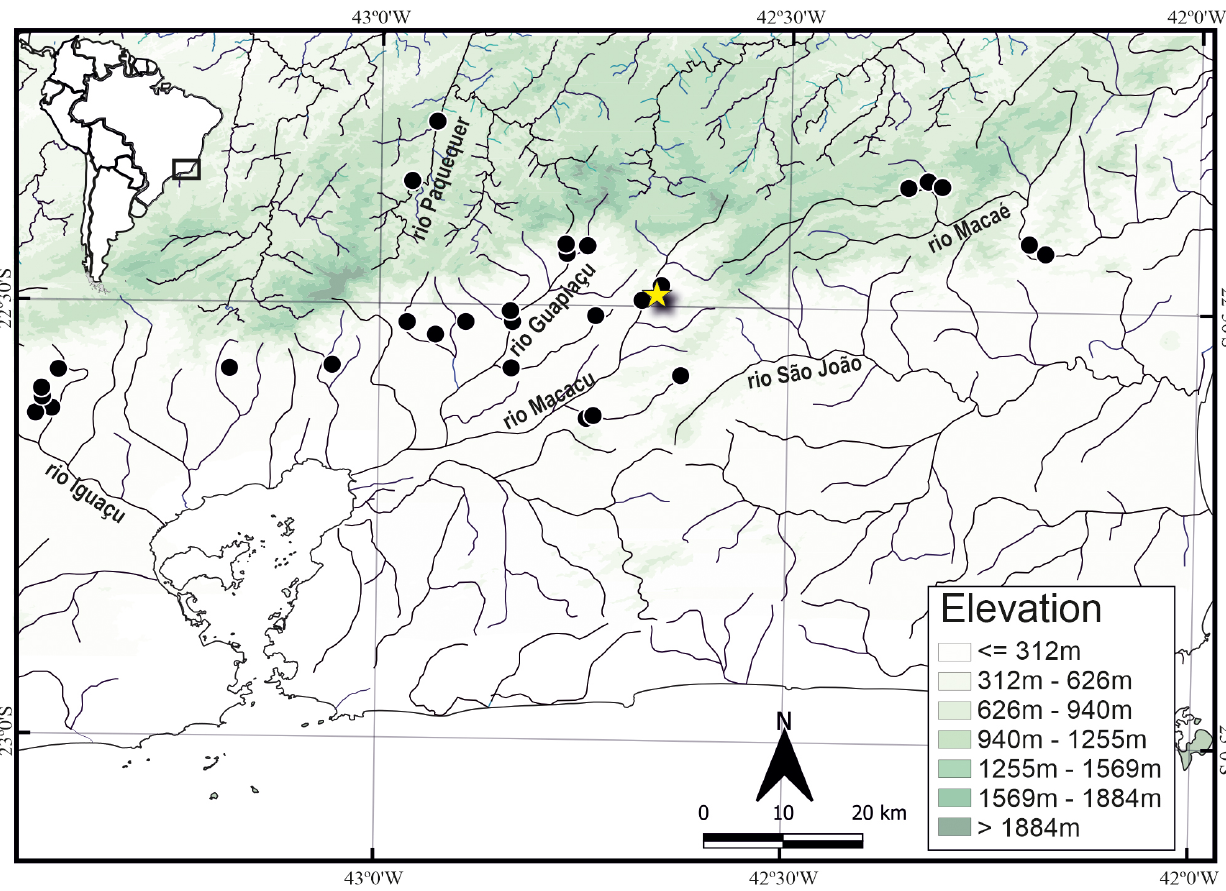
FIGURE 5 | Geographic distribution of Rineloricaria nudipectoris . Star represents the type-locality; black circles may represent more than one collection event in the same